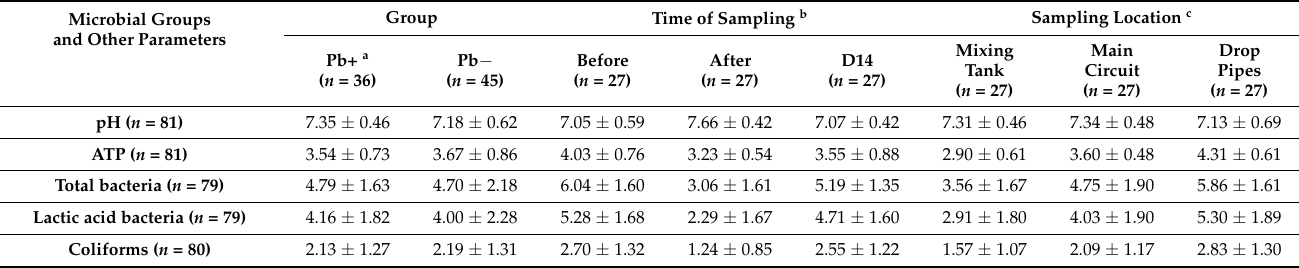
Table 6. Microbiological counts (log 10 CFU/g), ATP readings (relative light units) and pH ( ± SD) of contact water sampled at different locations on nine pig farms before, immediately after and 14 days after extensive cleaning of the liquid feeding systems (adapted from Royer et al. [84]).